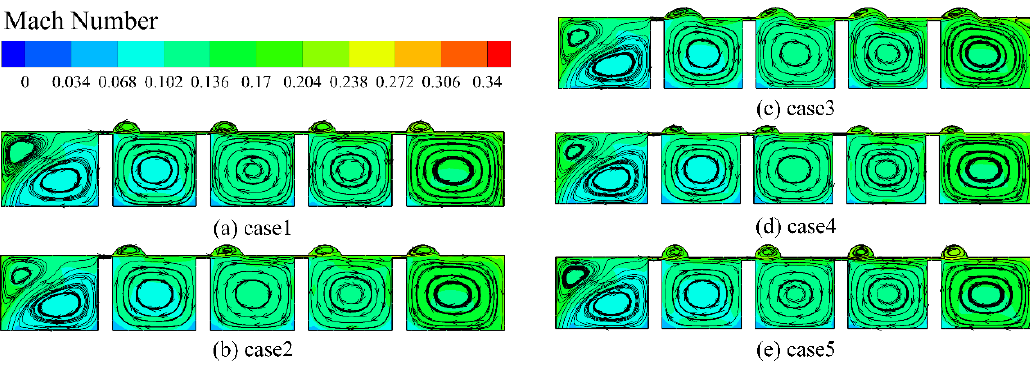
Figure 17. The Mach number contours of meridional plane of leakage passage on rotor of case1 – 5.